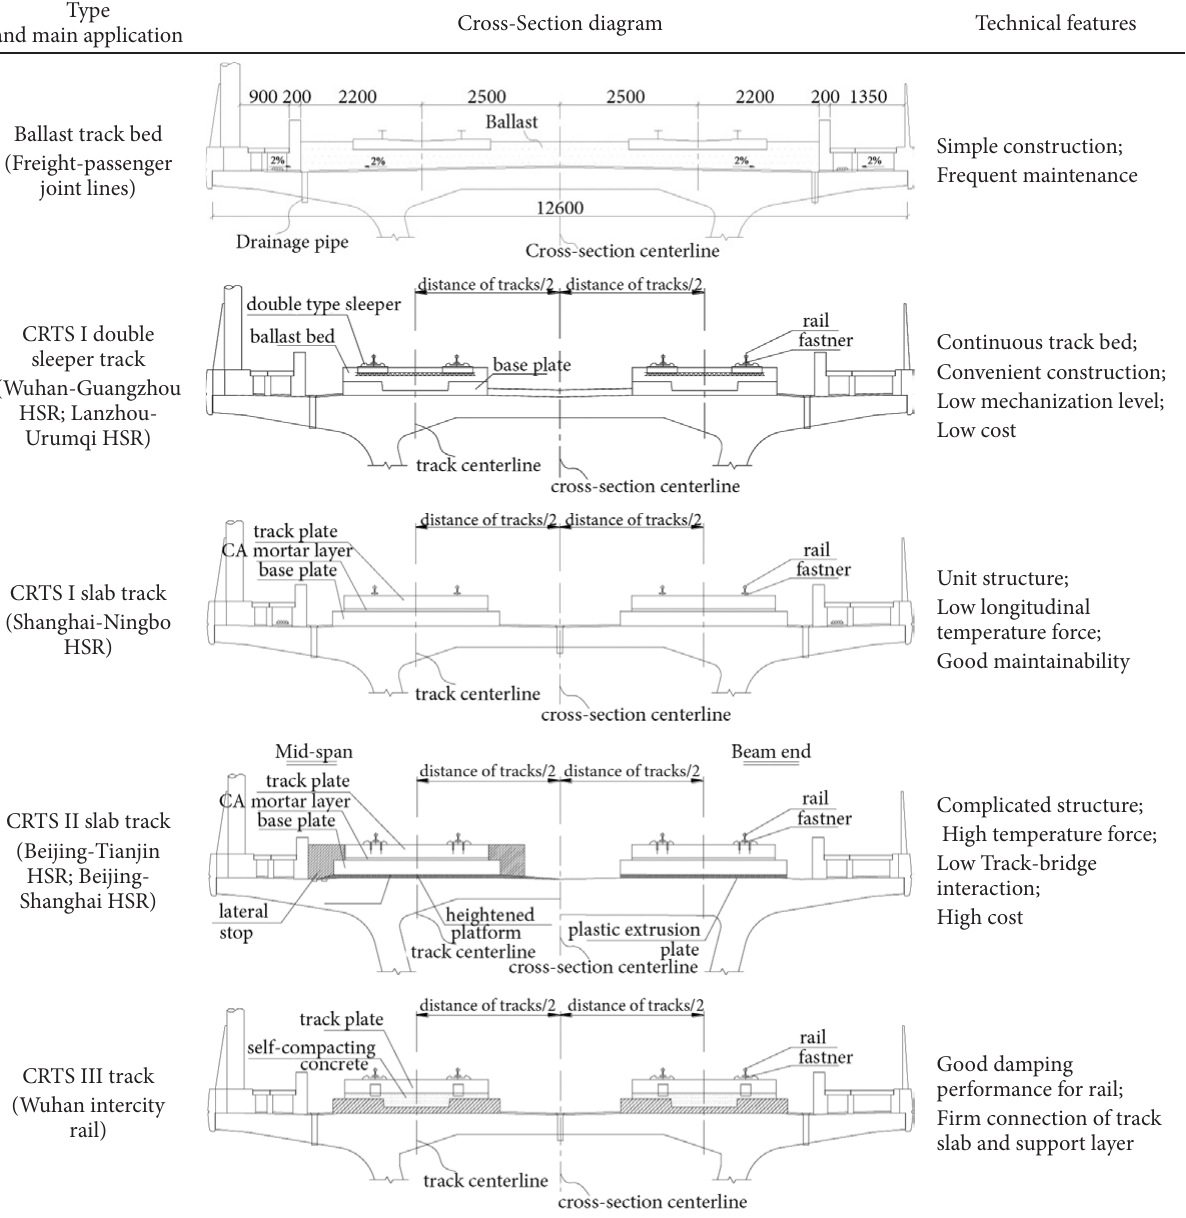
Table 2. Track structure types for the HSRs in China Type and main